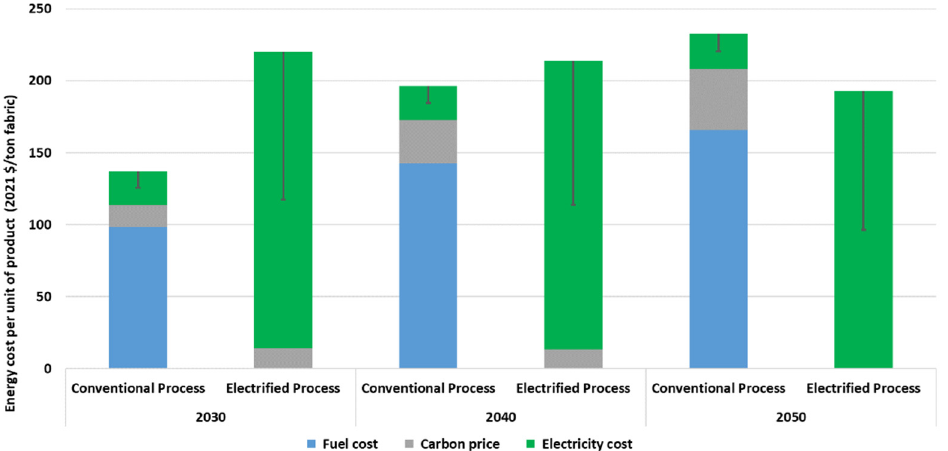
Figure 19. Energy cost per unit of production for conventional and electrified dyeing process in Japan.